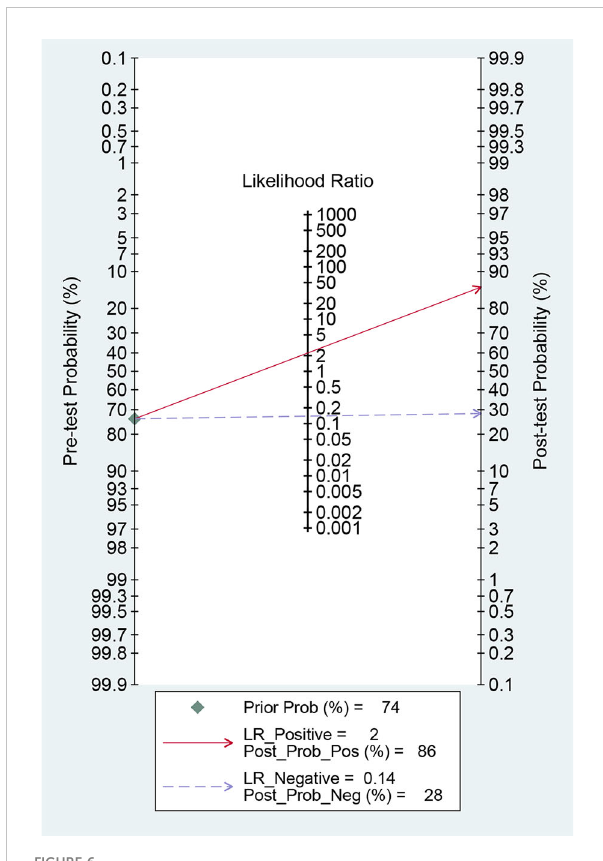
FIGURE 6 The Fagan plot; the pre-test probability is the mean of prevalence in the fi ve